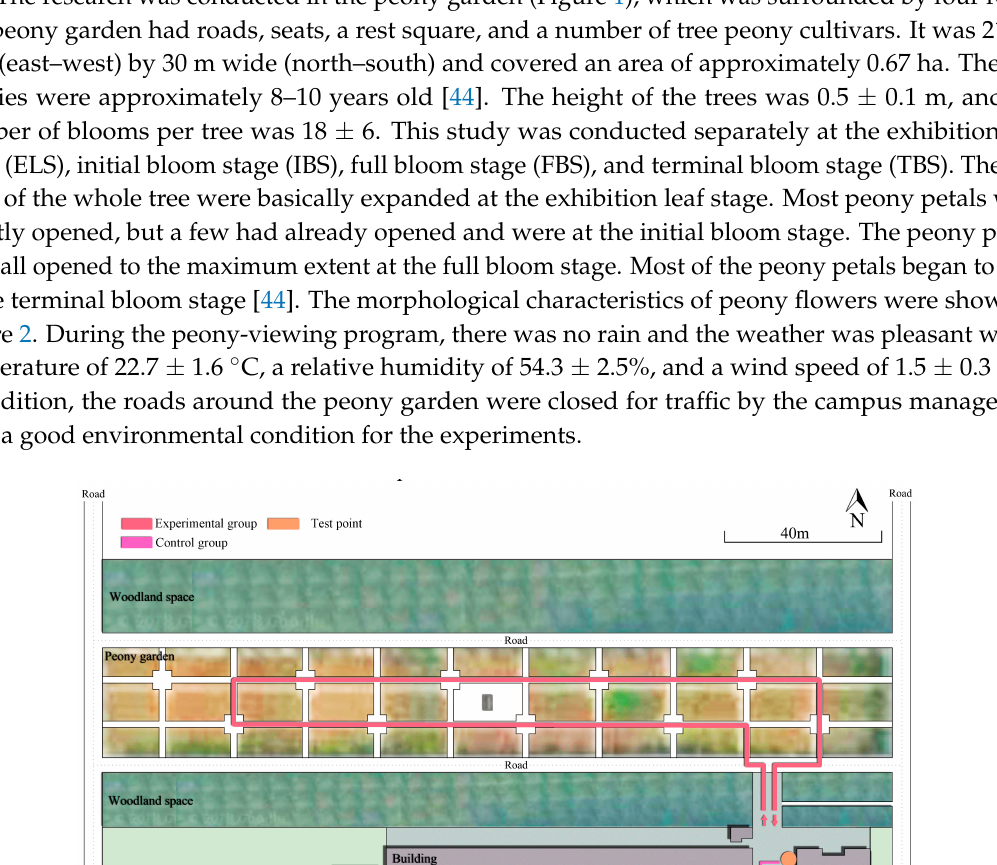
Table 1. Summary of sample